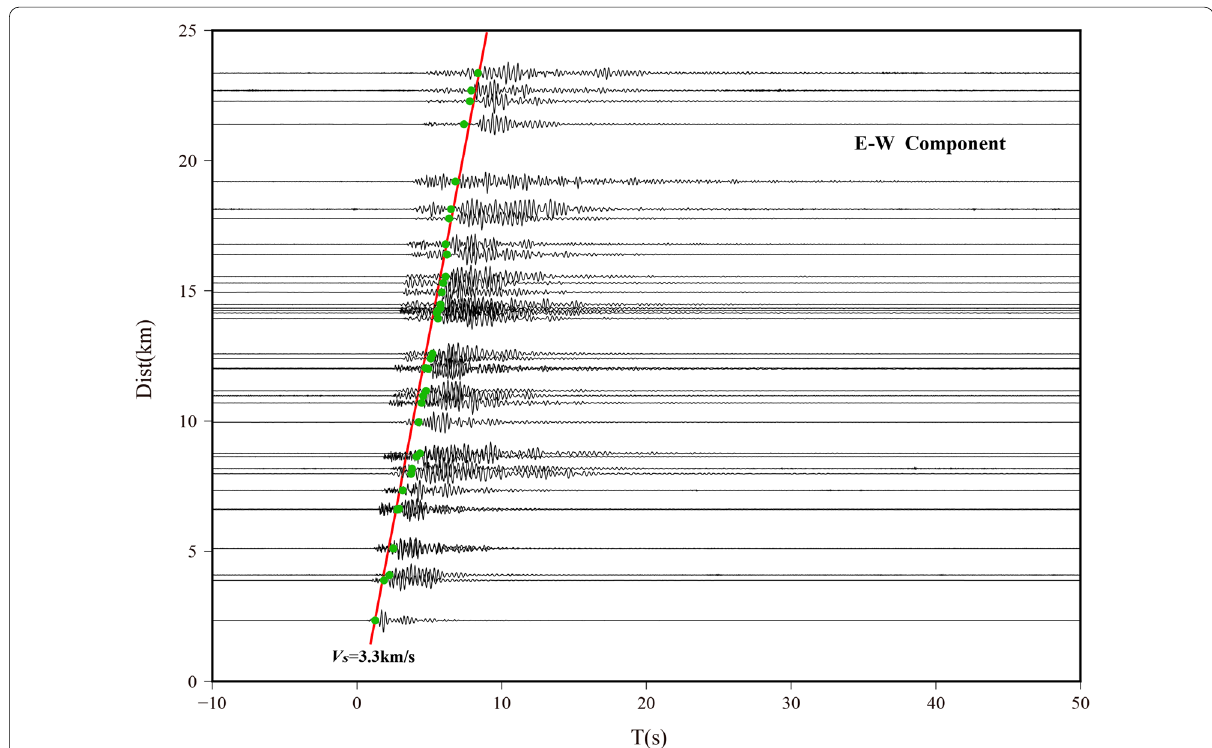
Fig. 3 Travel time curve of S waves. The epicentral distance from the shot point is labeled on the left. The green dots indicate the picked onset of S waves manually, and the slope of red line is 3.3 km/s. The amplitudes at all stations are reduced by a factor of 0.5